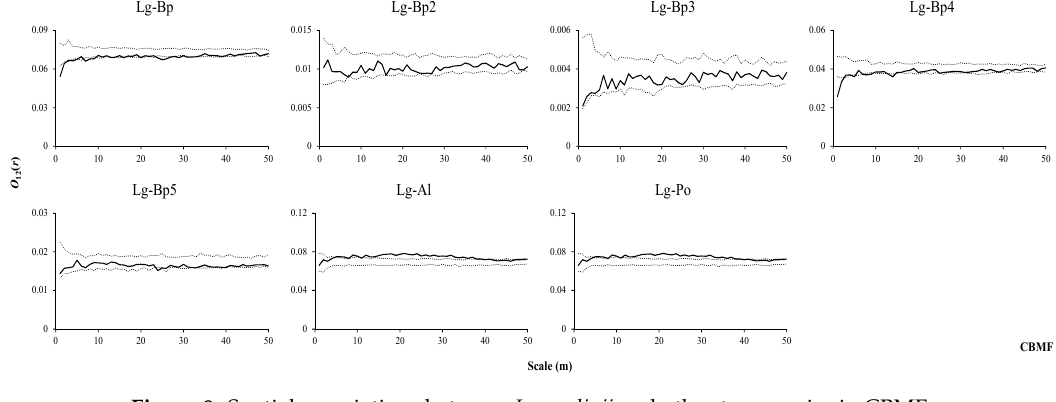
Figure 9. Spatial associations between L. gmelinii and other tree species in CBMF.